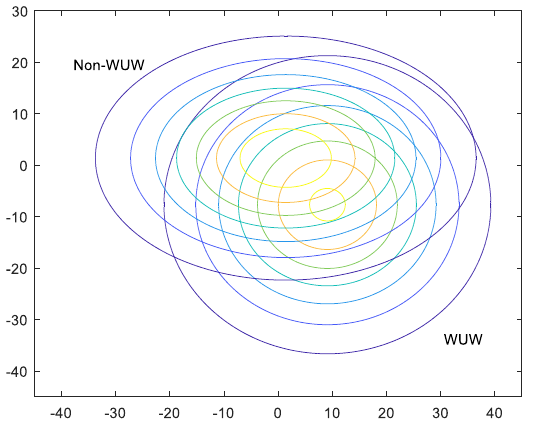
Figure 4. Distribution contour curves of two-dimensional vector obtained through PCA transform of the competing-words based features for WUW and non-WUW speech utterances.